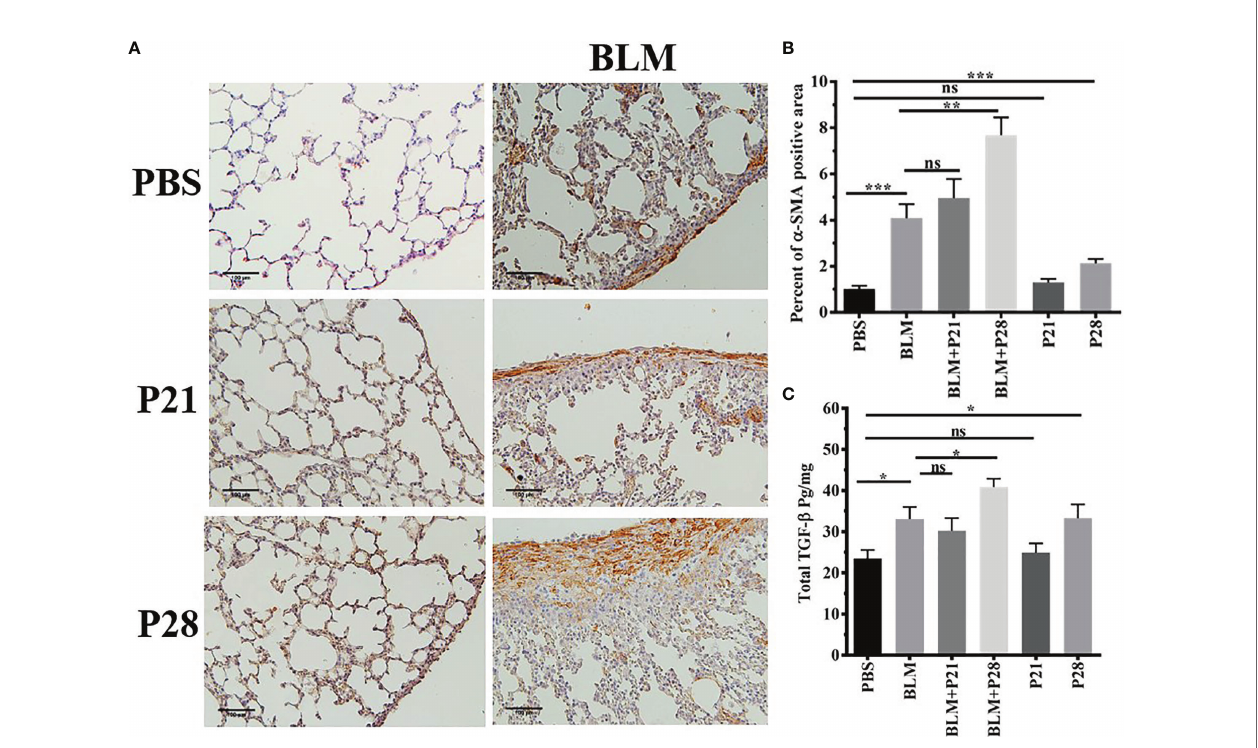
FIGURE 2 | Progesterone increases expression of a -SMA and TGF- b in fi brotic lung tissue. (A) 5 µm sections of paraf fi n embedded left lungs were taken. Slides incubated with anti a -SMA antibody, stained with Diaminobenzidine and counter - stained with Haematoxylin. Original magni fi cation = 200X. Scale = 100 m m (B) Quantitative expression of a -SMA in lung tissues. (C) TGF- b in lung tissues. Results are represented as mean ± SEM, n= 5 - 10 mice in each group. Data were analysed with One – way ANOVA, Tukey multiple comparisons test. BLM, Bleomycin; P, Progesterone; ns, non -signi fi cant, *** = P < 0.001, ** = P < 0.01, * = P <